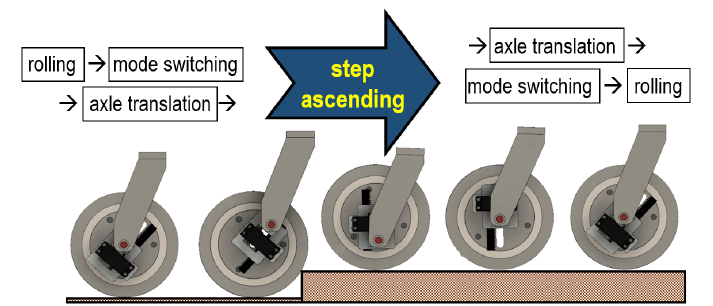
Figure 8. Step-ascending mode performed by wheel mechanism.